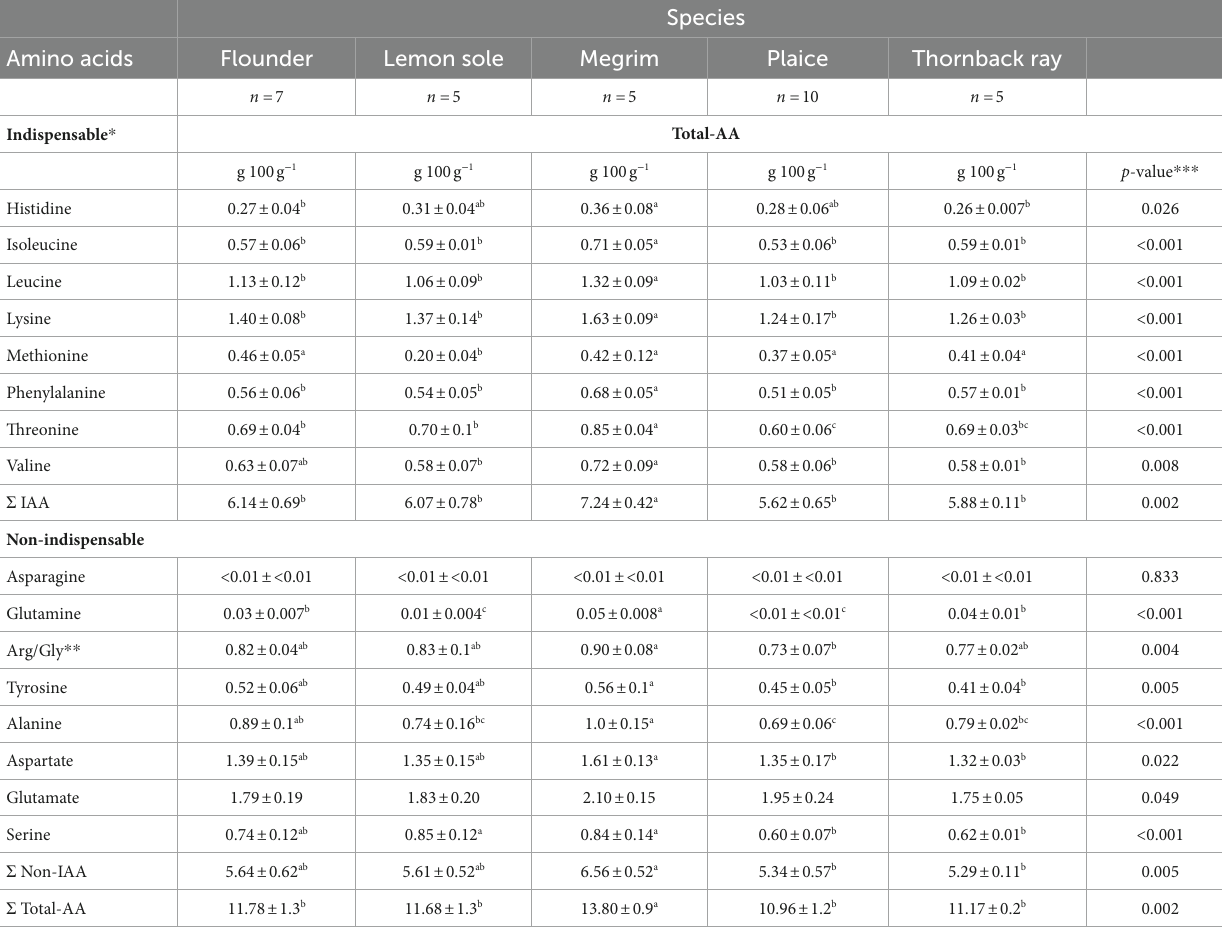
TABLE 2 Total amino acid contents (total-AA) in g/100 g central fillets of flounder, lemon sole, megrim, plaice and thornback ray, showing indispensable (IAA) and non-indispensable amino acids (non-IAA).